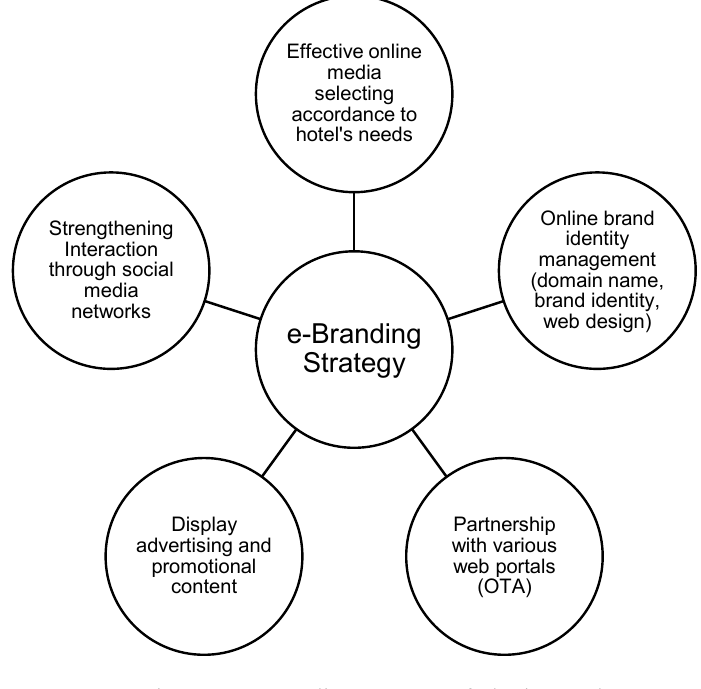
Figure 1. E-Branding Strategy of Sharia Hotel (Source: Data processed by